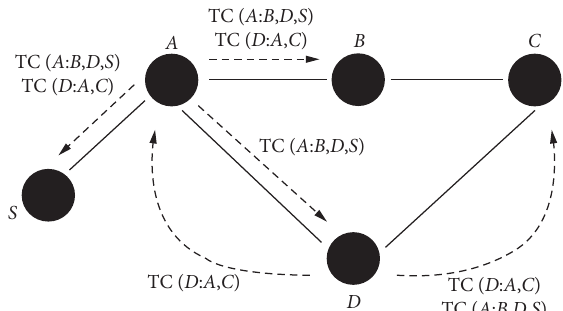
Figure 4: Continuation of the working principle of the OLSR [8, 9,